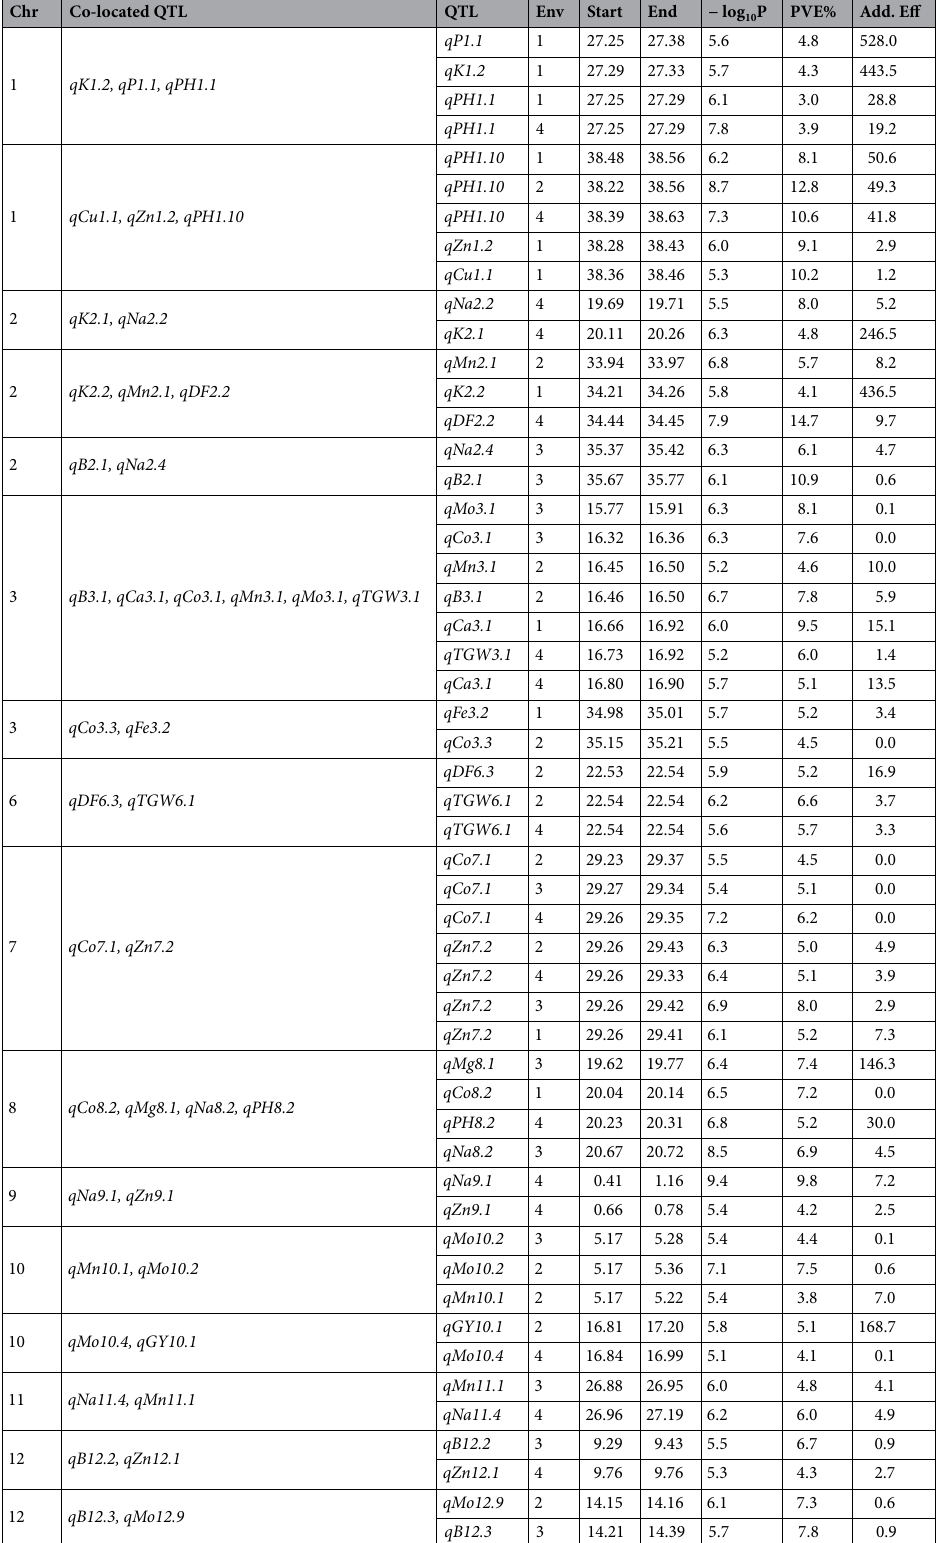
Table 3. Summary of the co-localised QTL. Env environment (1 = IRRI 2012, 2 = IRRI 2013, 3 = PhilRice2012, 4 = PhilRice2013), Chr chromosome, Start/End physical Mb position of the linkage block, Add. Eff estimated additive effect, PVE phenotypic variation